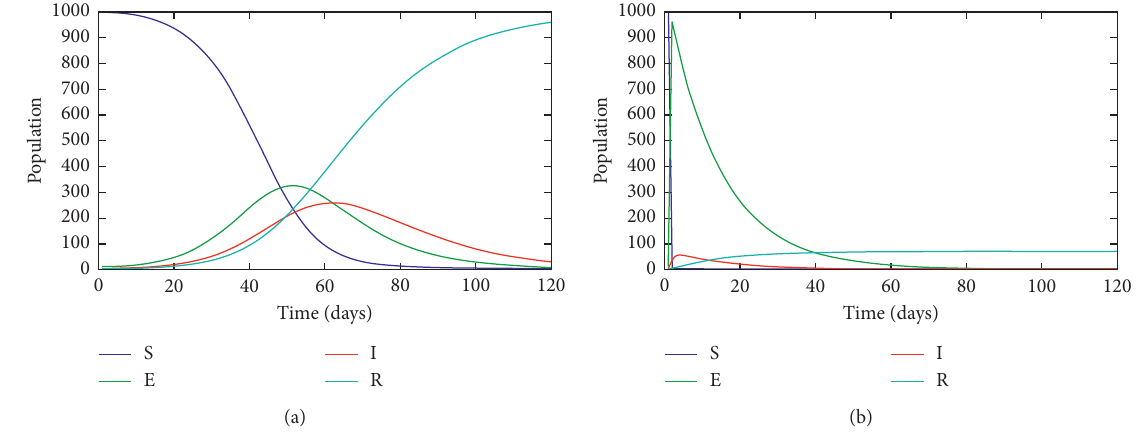
Figure 3: Variations of human subpopulation with time. (a) Crisp β , c and d . (b) Fuzzy β , c and d .